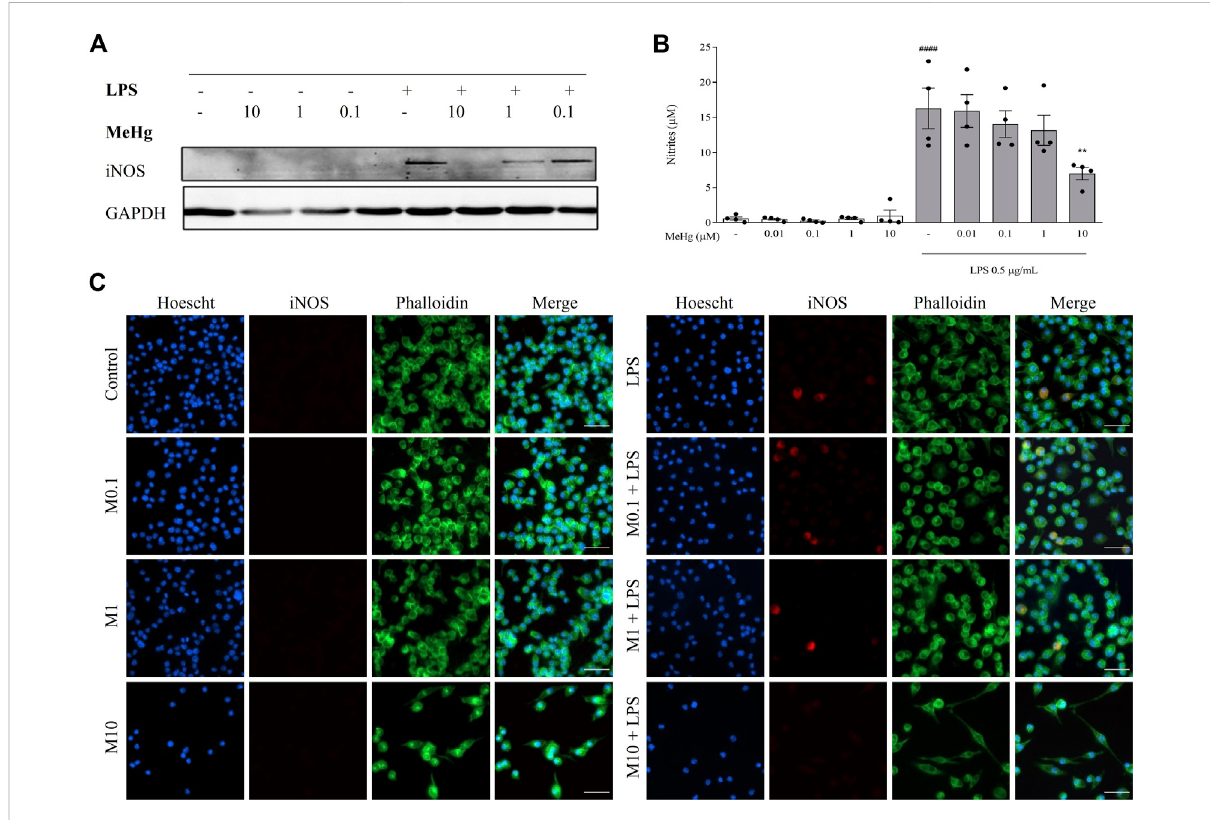
FIGURE 3 Effect of MeHg exposure (0.01, 0.1, 1 and 10 µM) on iNOS expression and nitrites production. (A) iNOS density and (B) nitrates levels were quanti fi edafterexposuretodifferentMeHgconcentrationsonBV-2microglialcelltreatedfor1 hsubsequentlystimulatedwithLPSfor24 h.GAPDH wasusedastheloadingcontrol. (C) RepresentativeimagesofHoechst33342(blue),iNOS(red)andPhalloidin(green)labelledcells,obtainedthrough immunocytochemistry. Scale bar, 50 μ m #### p < 0.0001 vs. Control; ** p < 0.01 vs. LPS. Data are expressed as Mean ± SEM, n = 4. One-way ANOVA followed by Bonferroni ’ s multiple comparisons